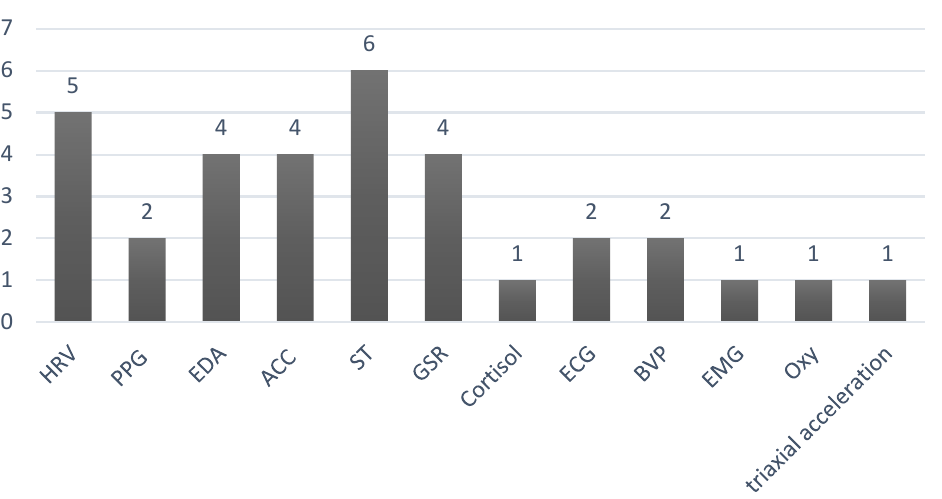
Figure 5. The biomarkers parameters that were mentioned in the selected studies. The X-axis corresponds to the physiological and chemical parameters; the abbreviation list is provided in the appropriate section at the end of this paper. The Y-axis presents the number of times that each parameter appeared in the papers investigated.